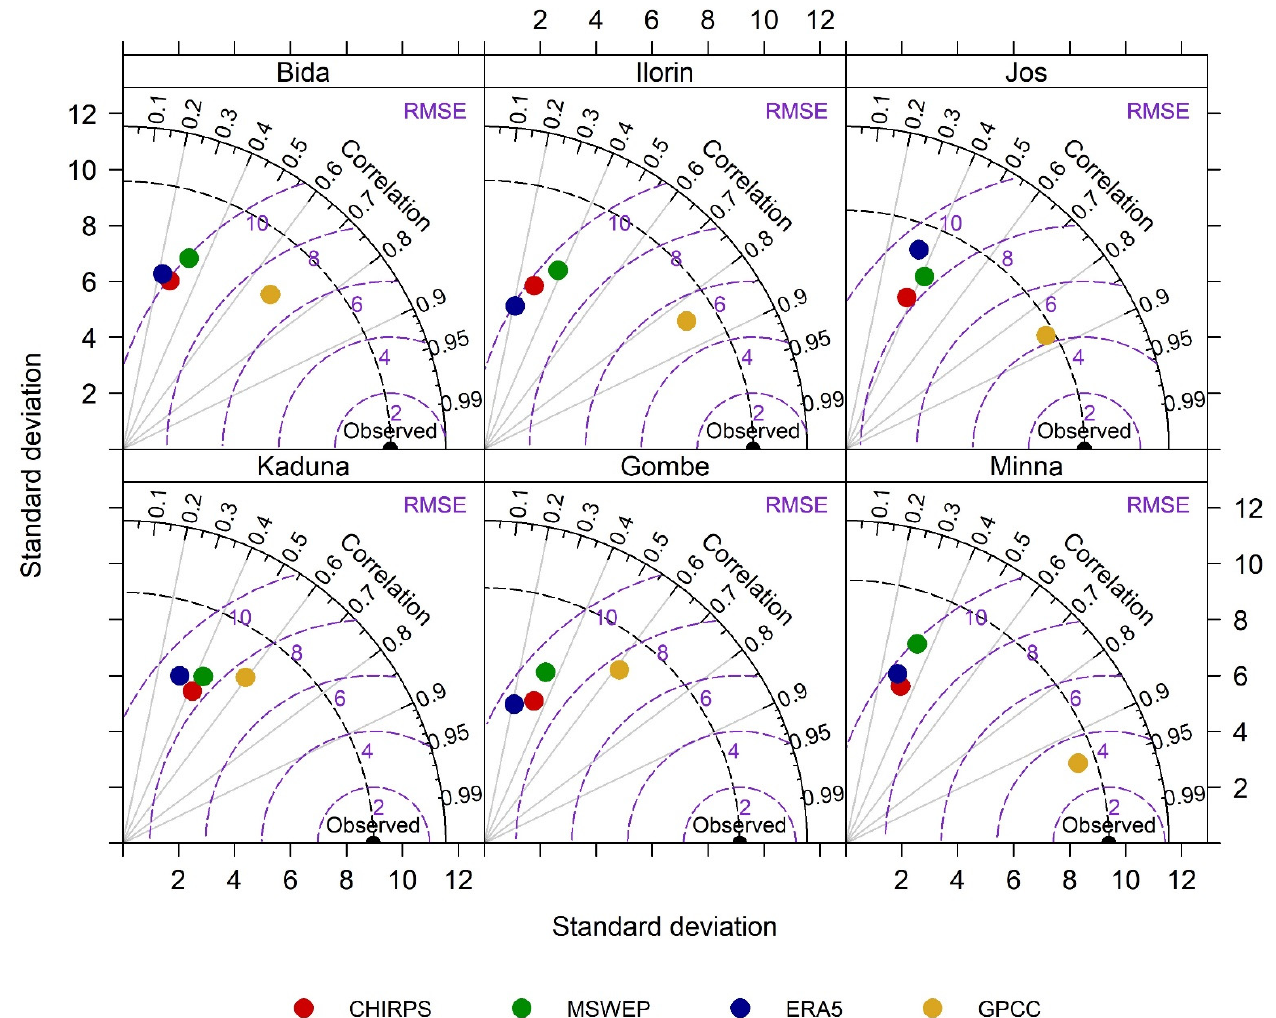
Figure 4. Taylor diagram of synoptic stations within Savannah climatic region.